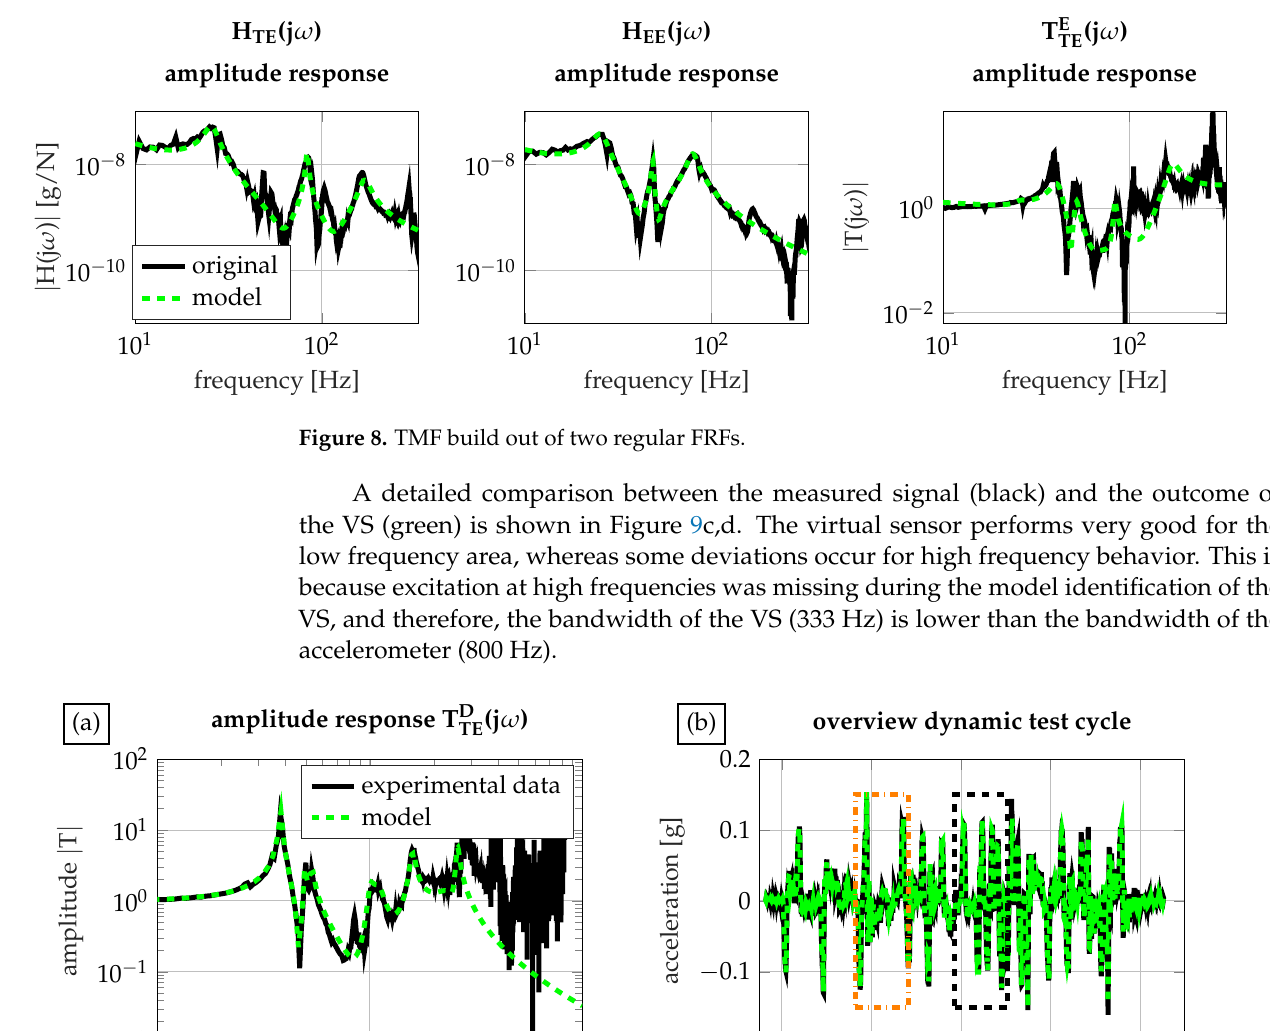
because excitation at high frequencies was missing during the model identification of the accelerometer (800 Hz).